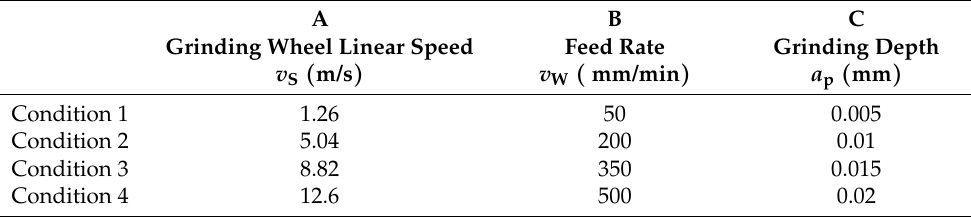
Table 3. C/SiC composite end grinding process parameters ( f = 33.9 kHz,A ≈ 6 µ